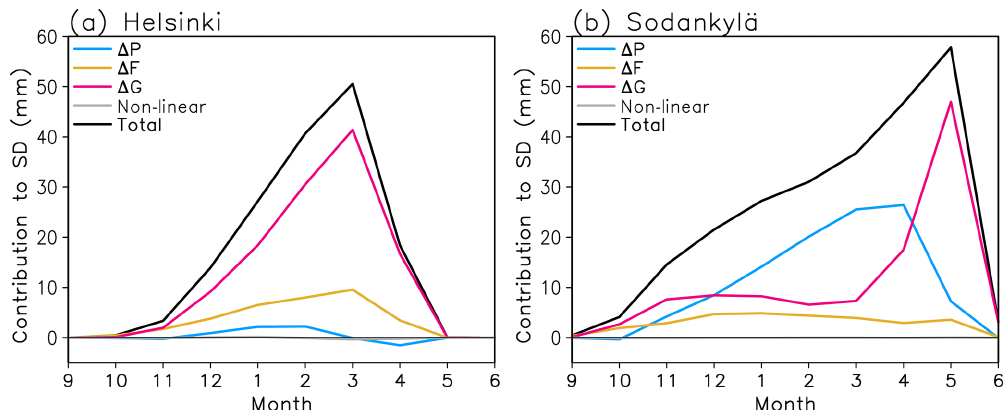
Figure 6. (a) Interannual standard deviation of SWE (black line) in Helsinki and the contributions of the four rhs terms in Eq. (2) to it (coloured lines) based on ERA5-Land. (b) The same for Sodankylä.